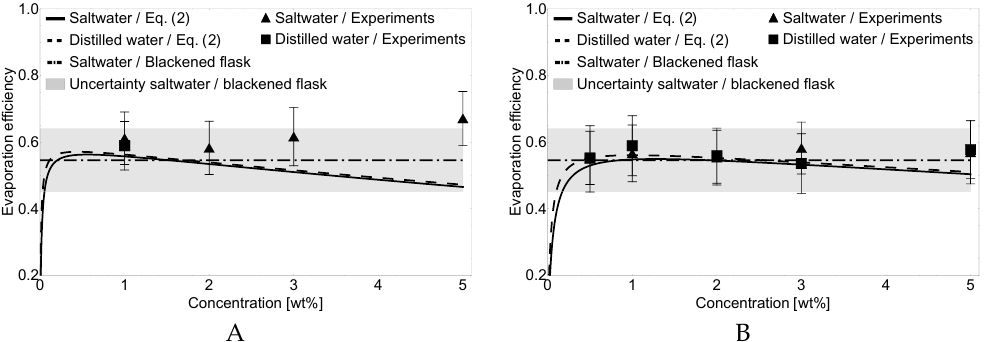
Figure 4. Evaporation efficiency as a function of particle mass concentration for carbon nanotubes MWCNT ( A ) and iron oxide Fe 3 O 4 nanoparticles ( B ). The experimental results (points) are compared to the calculations according to Equation (2) (lines). The evaporation efficiency for the saltwater in the blackened flask (dash-dotted line) and corresponding uncertainty are plotted for